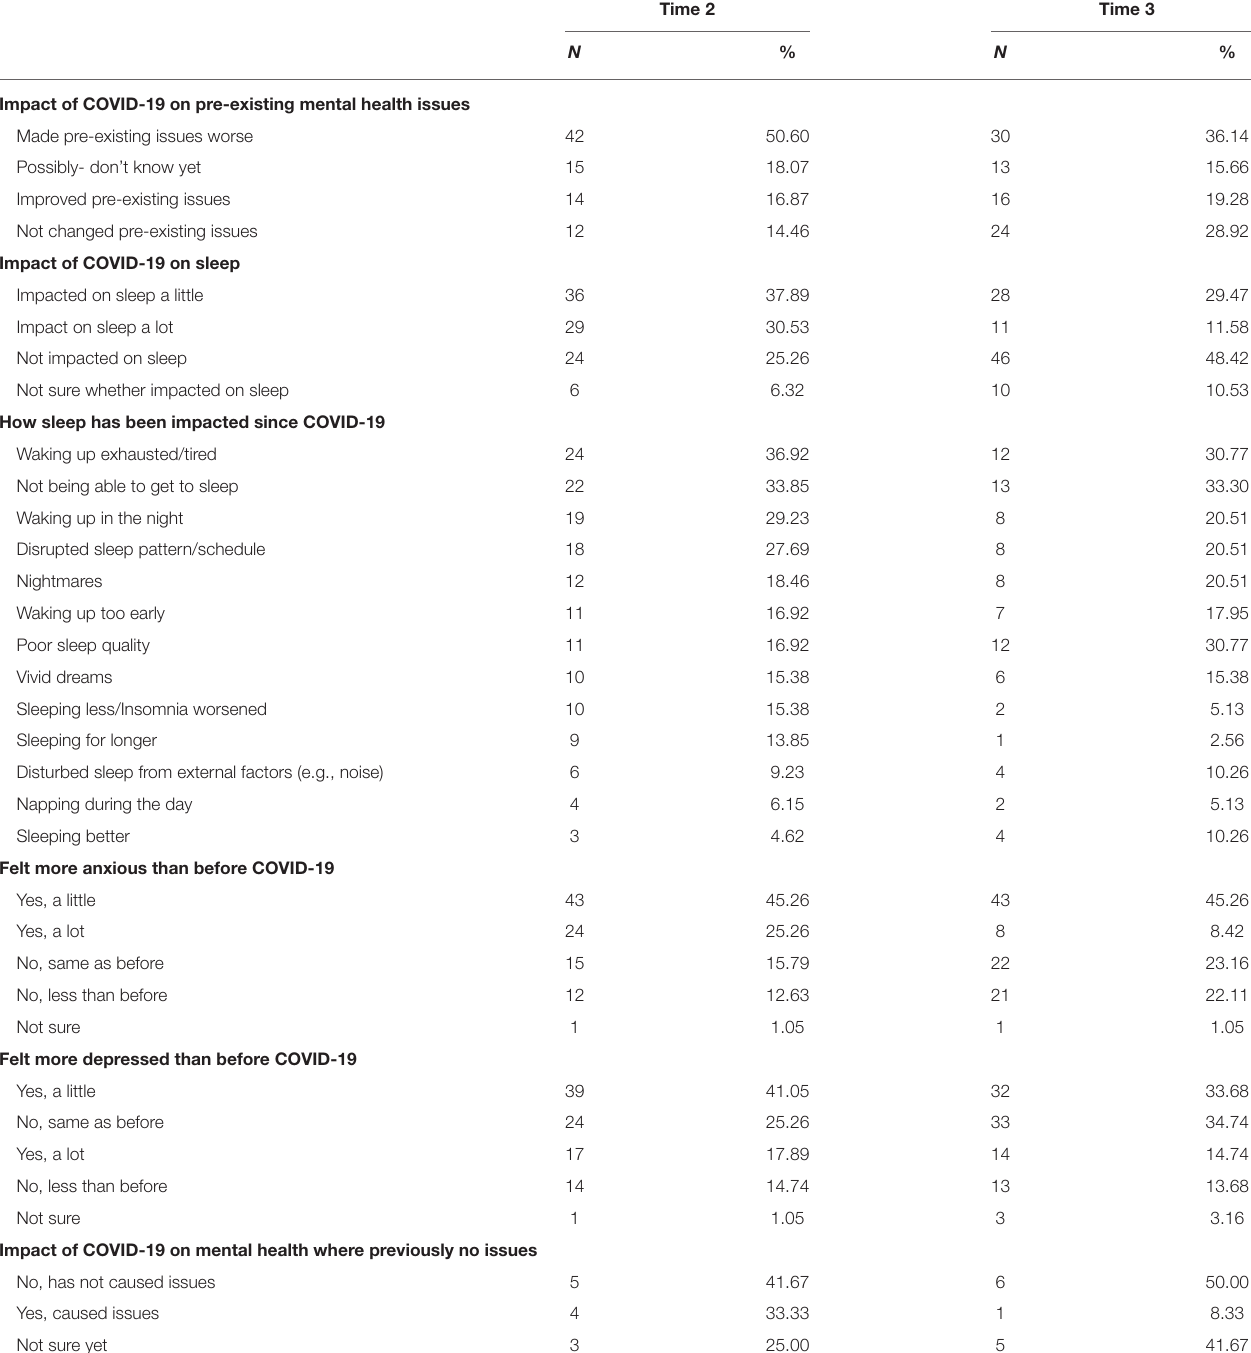
TABLE 2 | Mental health and sleep outcomes as a result of the COVID-19 pandemic in autistic adults. Time 2 Time 3 N % N